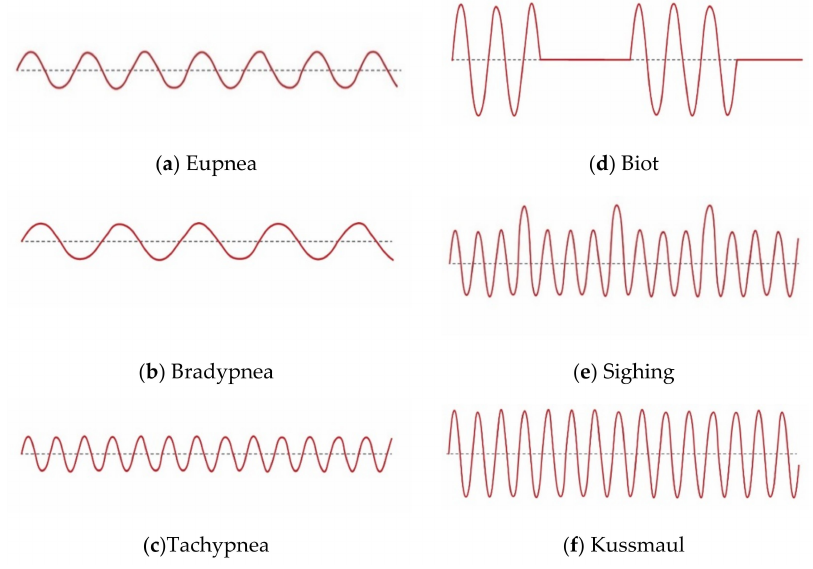
Figure 1. Different breathing